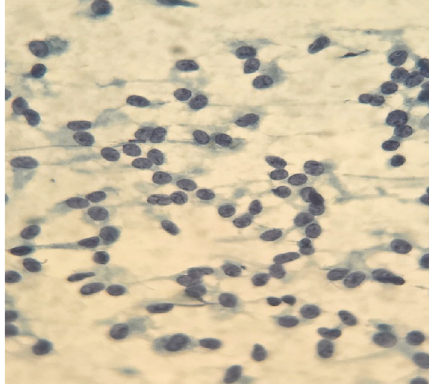
Figure 4: High power image shows cells with round to oval nuclei with fine chromatin and inconspicuous nucleoli and some with characteristic nuclear grooves.